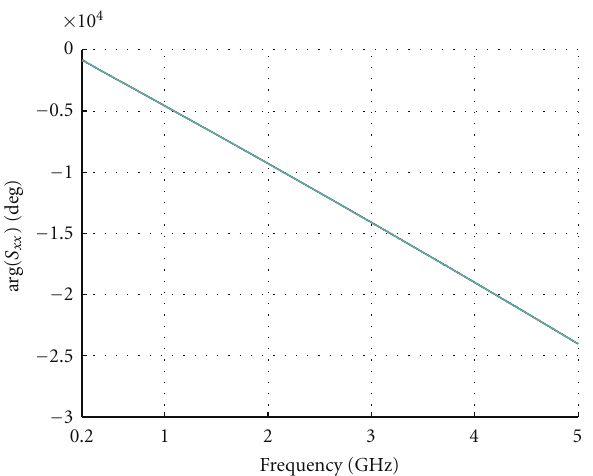
Figure 10: Full width at half maximum (FWHM): Simulation and measurement.